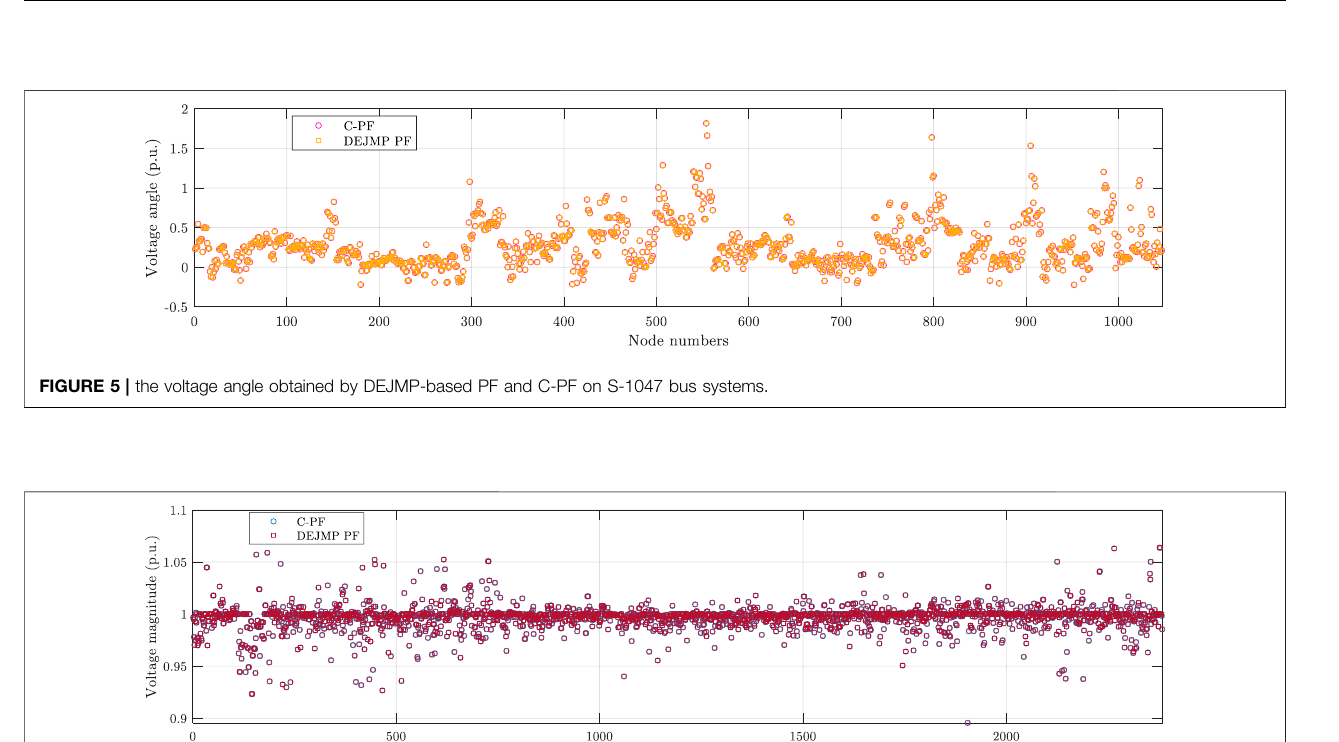
FIGURE 4 | the voltage magnitude obtained by DEJMP-based PF and C-PF on S-1047 bus systems.